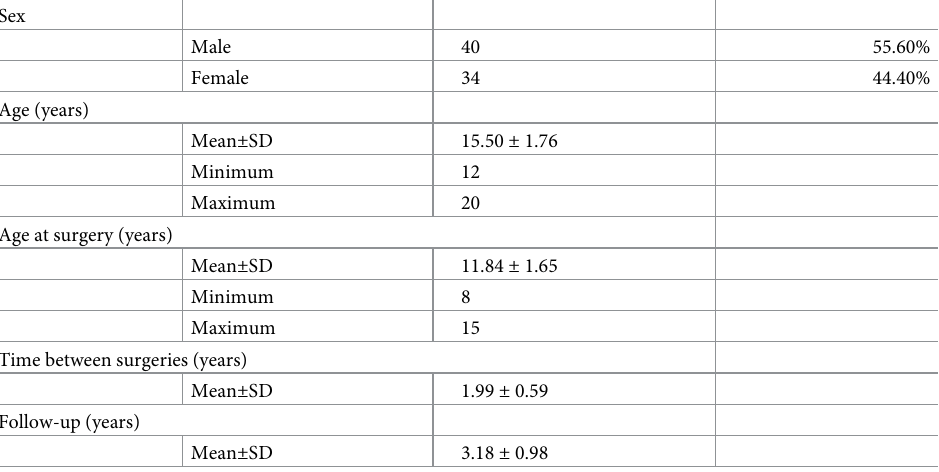
Table 1. Demographic data, age at surgery, time between surgeries and length of follow up.